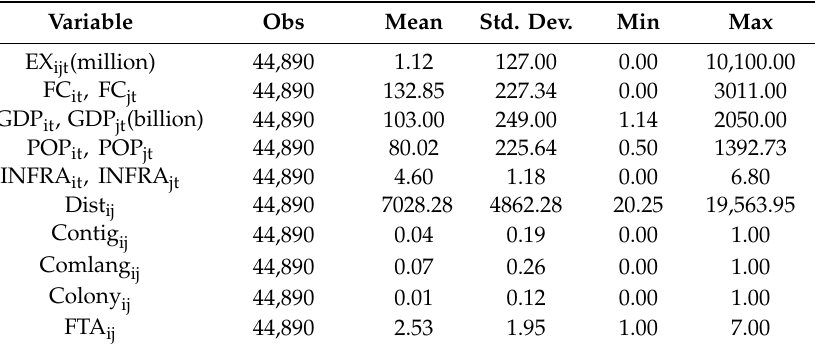
Table 5. Variable